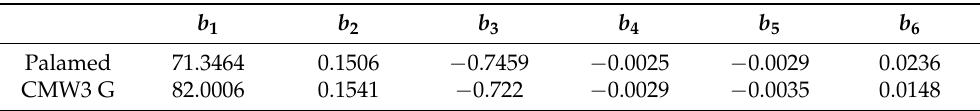
Table 3. Compressive strength model fitting